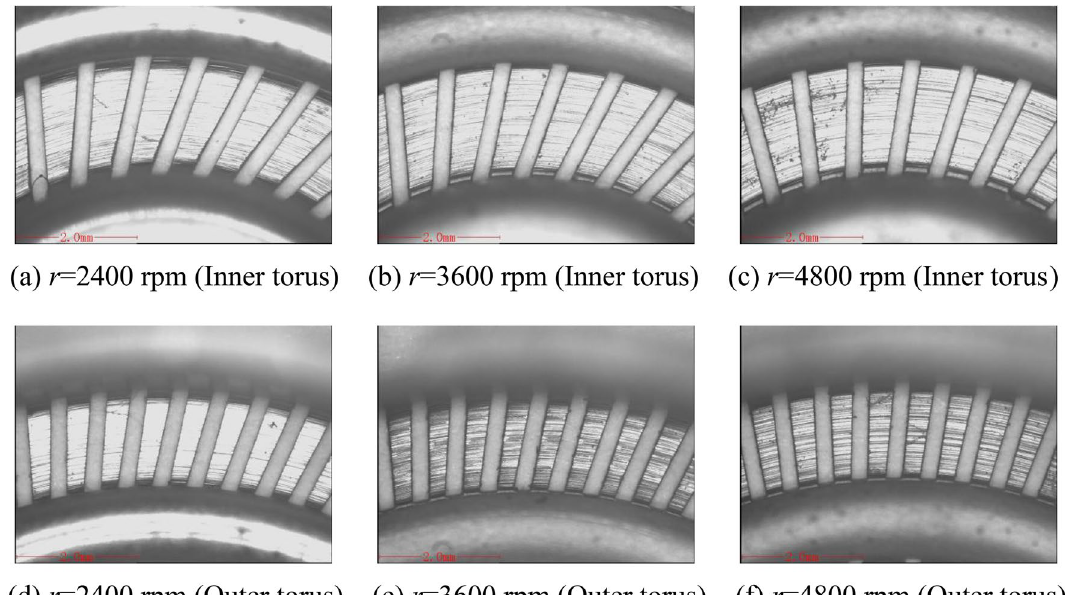
Figure 7. Inner and outer torus surfaces processed by different rotation speeds.